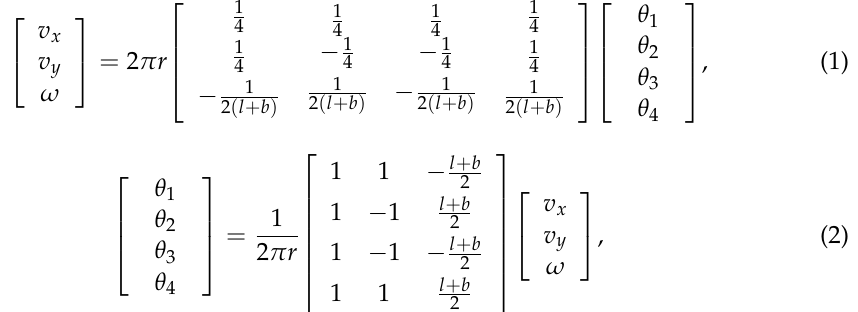
Figure 3. Omnidirectional chassis.